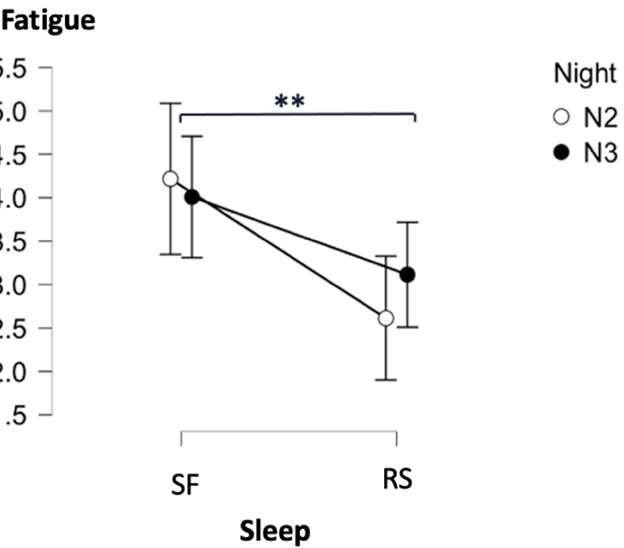
Figure 8. Visual analog scale for fatigue (VASf) prior to the TloadDback task. Note : ** p < 0.01. Error bars represent standard errors.